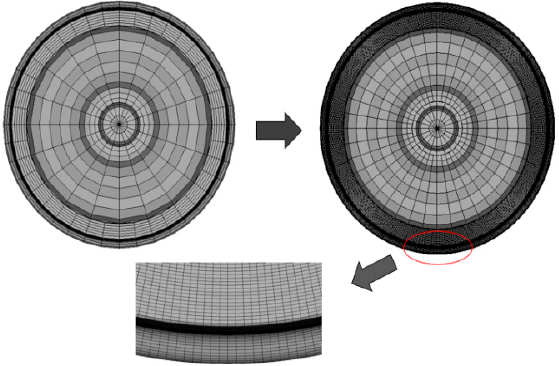
Figure 3. Finite element of wheel tread and flange.